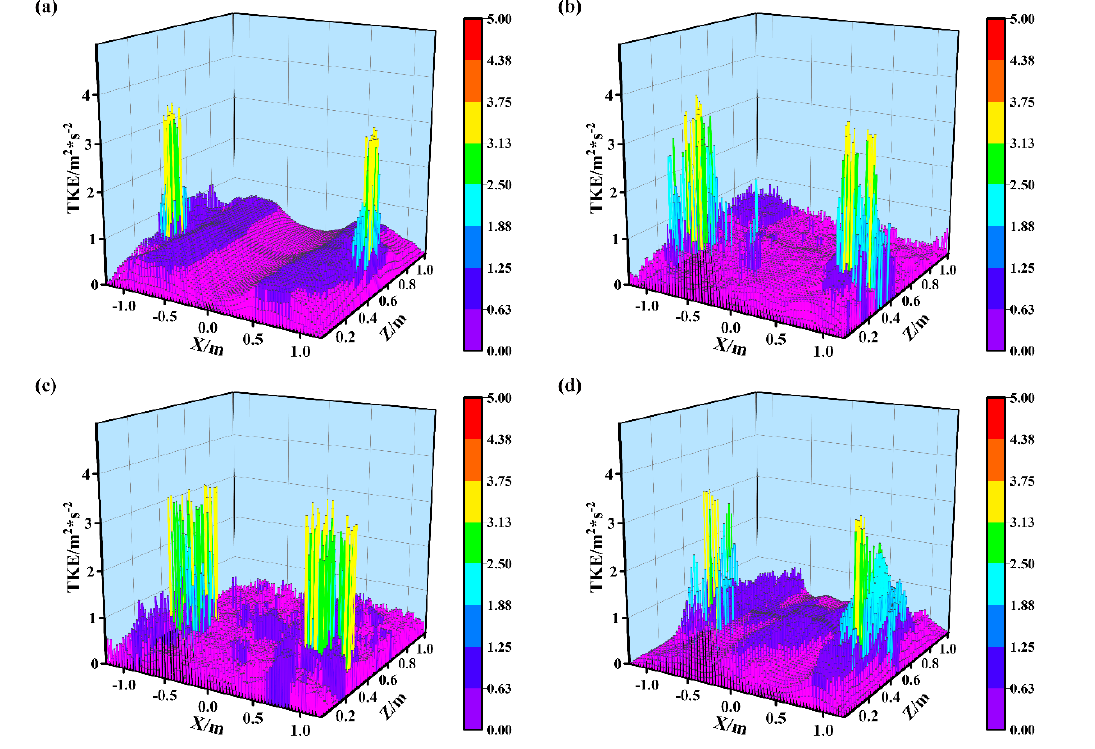
Figure 9. TKE distribution on y = 2.5 m section, ( a ) immersion depth 0.00 m; ( b ) immersion depth 0.04 m; ( c ) immersion depth 0.08 m; ( d ) immersion depth 0.12 m.